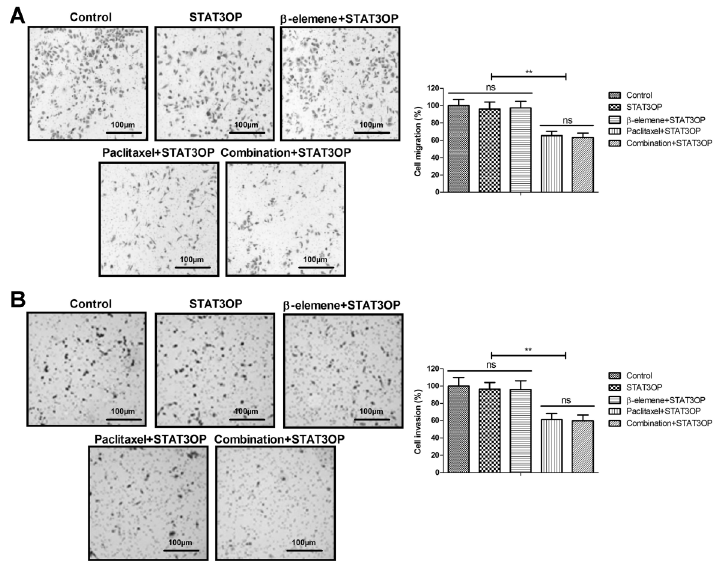
Figure 6. Effects of STAT3 overexpression (STAT3OP) on b -elemene + paclitaxel-regulated migration ( A ) and invasion ( B ) of SKOV3 cells. Data are reported as means ± SD. **P o 0.01 (ANOVA followed by Tukey ’ s multiple comparison post hoc test). ns: not signi fi